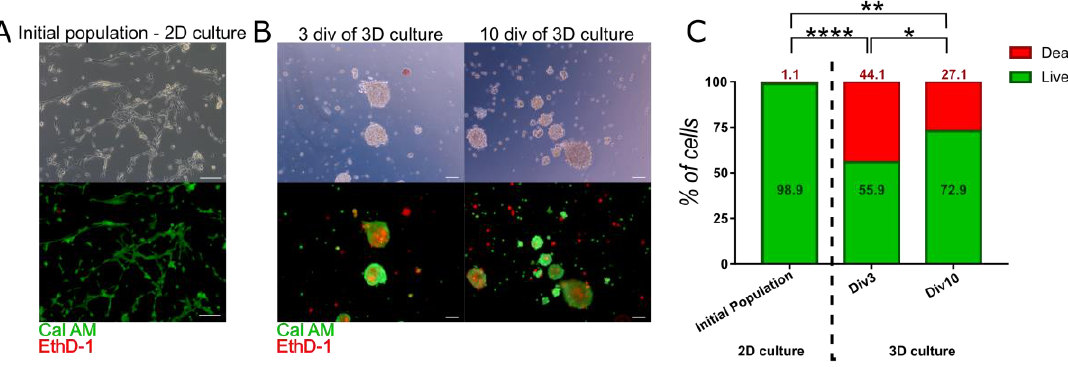
Figure 2. Viability of 3D cultured WJ-MSC—Calcein AM (Cal AM) and Ethidium homodimer-1 (EthD-1) staining. Cal AM stains live cells in green, while EthD-1 stains dead cells in red. Double stained cells are early apoptotic cells. ( A ) Initial population of WJ-MSC contained live cells with almost no dead cells. Scale bars: 100 µ m. ( B ) Viability of cells in spheroids— after 3 and 10 div (day in vitro) of 3D culture. Observed darker shade in the contrast phase corresponds to dead cells visible. Scale bars: 100 µ m. ( C ) Analysis of live, dead, and early apoptotic cells in initial population and 3D cultured population for 3rd and 10th (div). The results are presented as mean values of 3 experiments ± SD, for * < 0.05, ** <0.01, **** <